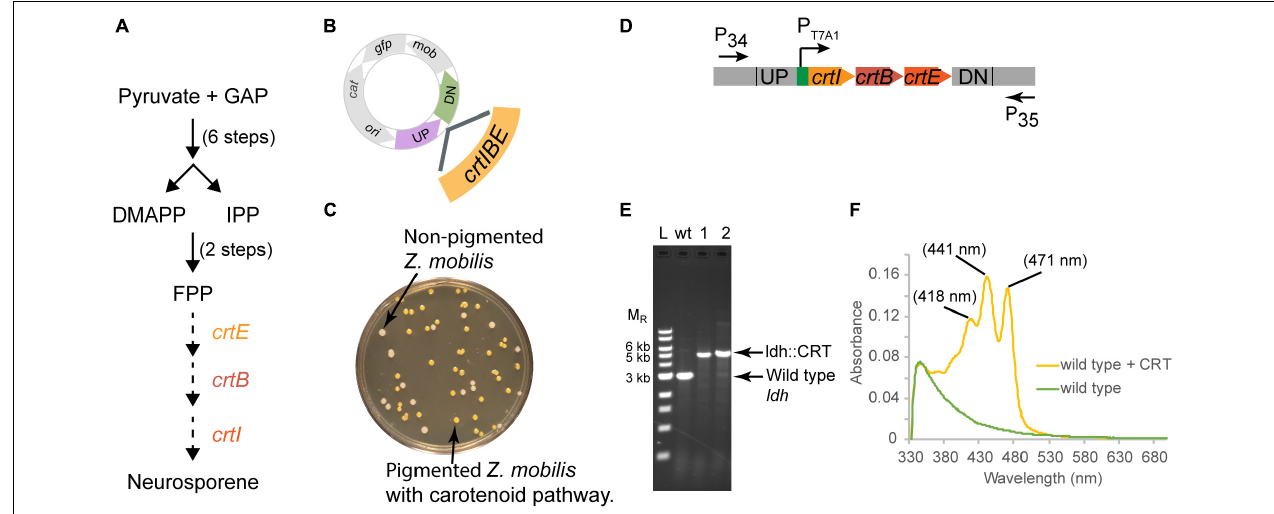
FIGURE 5 | Insertion of a functional CRT cassette. (A) A heterologous pathway for production of the carotenoid neuroporene by introduction of the crtIBE genes from Rhodobacter sphaeroides. Dotted arrows indicate the reactions mediated by the R. sphaeroides gene products. (B) Schematic of suicide plasmid used to deliver crtIBE to Z. mobilis ldh. UP and DN are the same 500 bp sequences used to delete the ldh gene. (C) Non-fluorescent candidates containing crtIBE replacing Z. mobilis ldh were isolated using the same workflow as outlined for ldh and screened for insertions first by the presence of orange colored colonies. (D) The location of primers used to distinguish between the wt and the insertion genotype is indicated by arrows. (E) Agarose gel electrophoresis of products from PCR amplification of orange colored colonies. Amplification using primers P 34 and P 35 yielded a DNA fragment of 5.4 kb for the insertion of crtIBE , whereas wt cells are expected to produce an amplicon of 2.9 kb. Selected size markers are indicated on the left (M R ). (F) Absorption spectrum of acetone:methanol extracts from orange colored colonies containing crtIBE compared to wt. Peak maxima characteristic of neurosporene are marked. We examined more than five isolates for insertion of the CRT cassette in independent experiments, and measured neurosporene from three different isolates. We conducted two independent experiments both resulting in the successful insertion of the CRT cassette at the ldh locus.